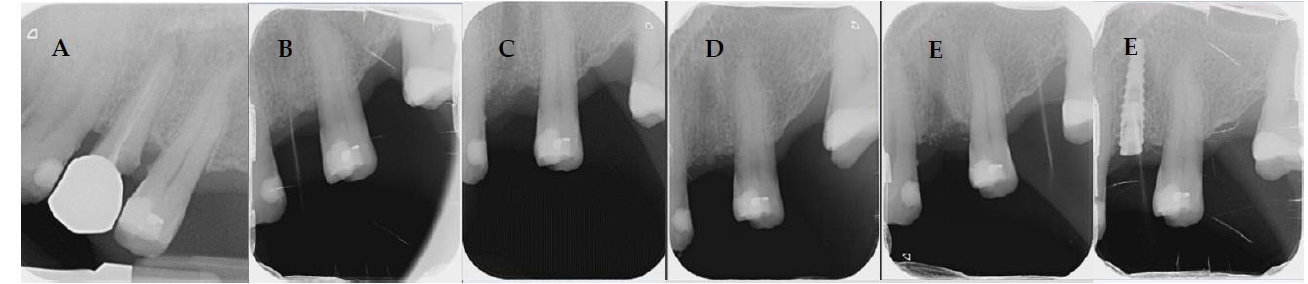
Figure 9. ( A ) Preoperative IOPA; ( B ) Immediate postoperative IOPA; ( C ) One week IOPA; ( D ) One month IOPA; ( E ) Two months IOPA; ( F ) IOPA after implant placement.